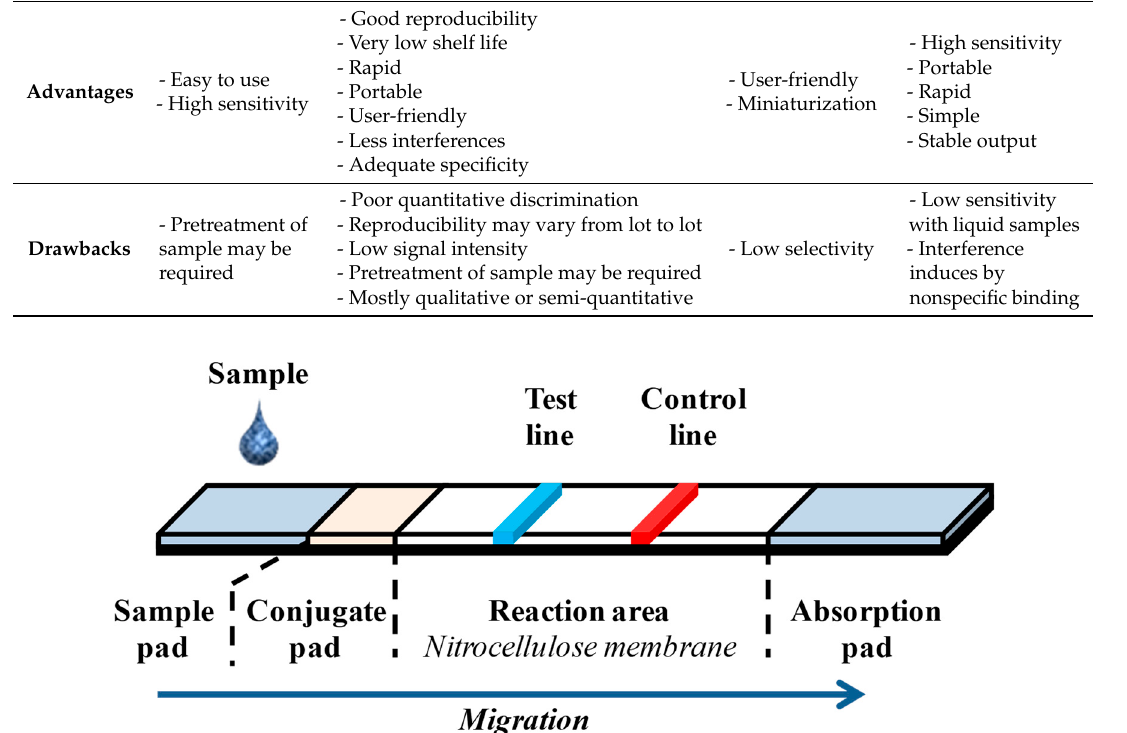
Figure 5. Structure of the lateral flow assay system. Table 3. Advantages and drawbacks of the biosensors and aptasensors technologies used for the detection of Salmonella in food.